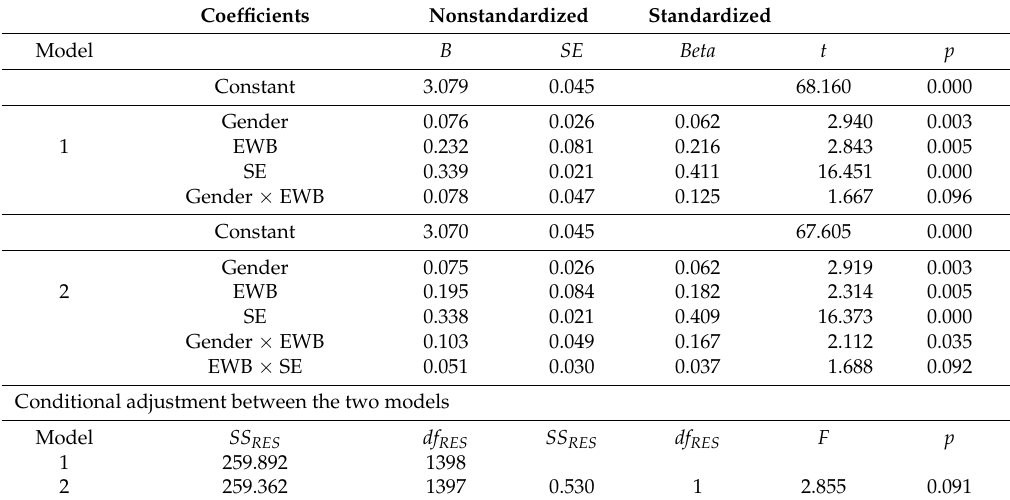
Table 3. Results of the hierarchical regression